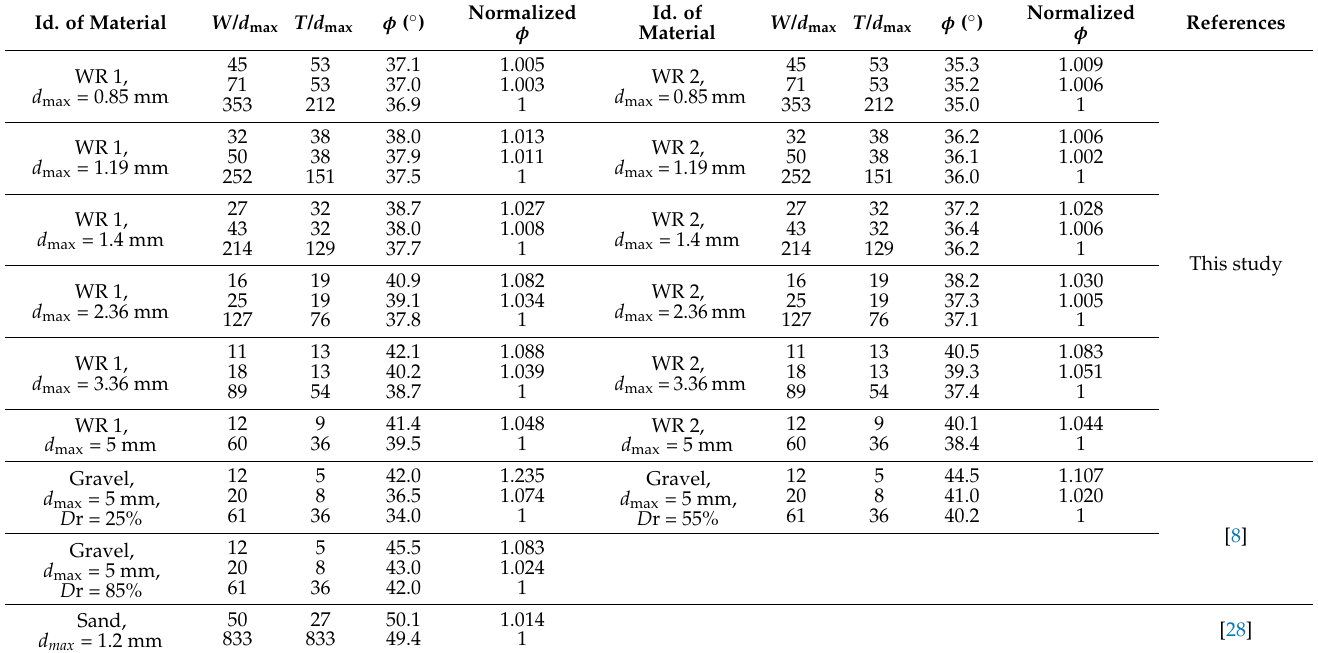
Table 12. Normalized friction angles of the experimental results obtained in this study and taken from the